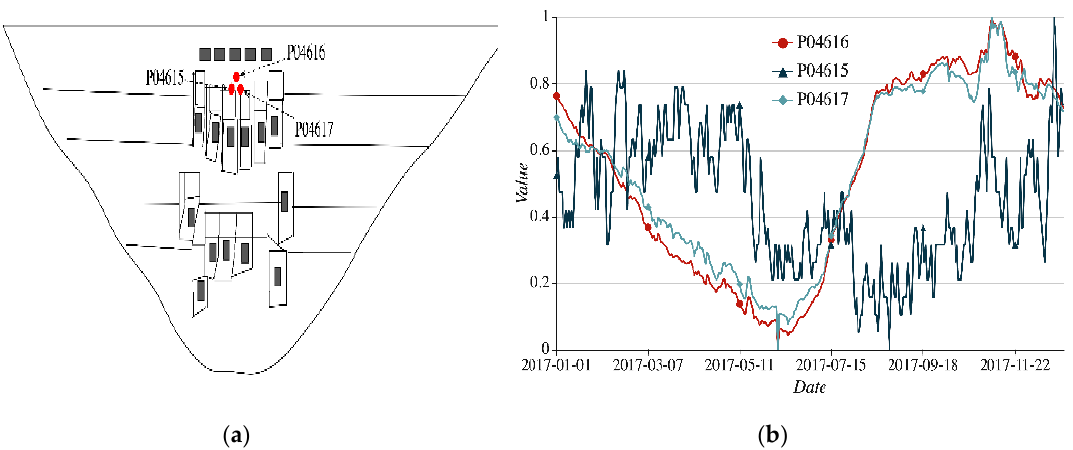
Figure 5. Spatial-temporal feature of nodes P04616, P04615, and P04617 ( a ) spatial distribution of three nodes; ( b ) sequential process lines of three nodes.